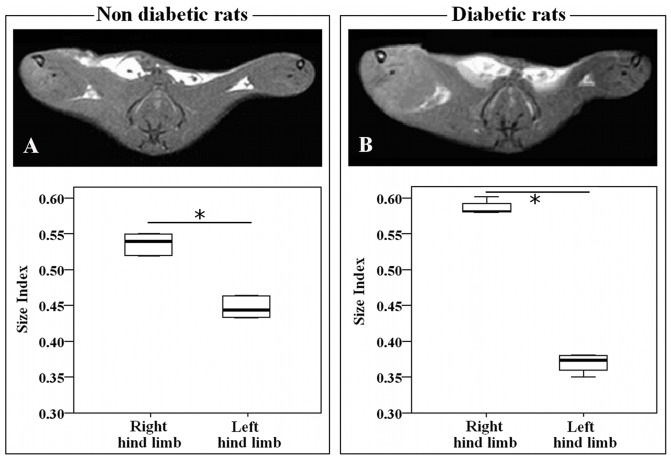
Representative T1-W images of the occluded and non-occluded hind limbs and morphometric outcomes.Left and right panels are referred to non-diabetic and a diabetic rat, respectively. Axial T1-W images show increase in soft tissue size due to regional swelling after right common iliac-femoral artery ligation in both non-diabetic (A) and diabetic (B) rat. Box and Whiskers Plots show the distribution of size indices of occluded [size index = right limb area/(right limb area+left limb area)] and of non-occluded limb [size index = left limb area/(right limb area+left limb area)]. Statistically significant differences were noted comparing the size index of occluded and non-occluded limb both in diabetic (n = 7) and non-diabetic (n = 6) rats. Significance level: * p<0.05. Box and Whiskers plot legend: the bottom and top of the box represent respectively the lower and upper quartiles; the bold band is the median; the ends of the whiskers represent the minimum and the maximum value.